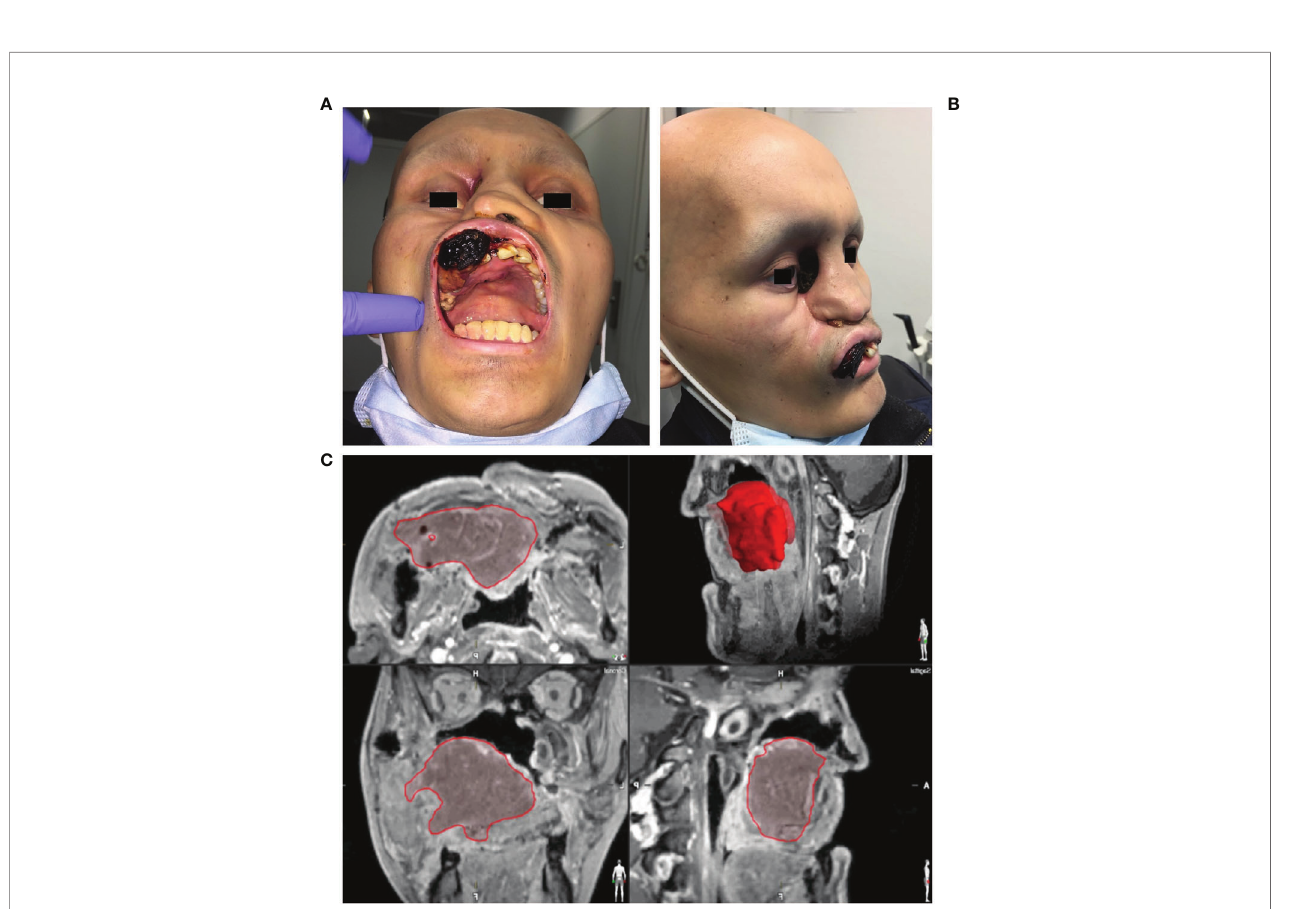
FIGURE 2 | Clinical fi ndings and virtual data in a case of Ewing ’ s sarcoma of the midface. (A) Frontal/intraoral and (B) side view of a 19-year-old patient with an Ewing ’ s sarcoma of the midface presenting with an ulcerating neoplasm in the area of the hard palate, the maxillary vestibule and the right medial nasal slope which has lead to a sinking of the right eyeball. (C) Segmented tumor extent (red) in the multi-planar view of the MRI